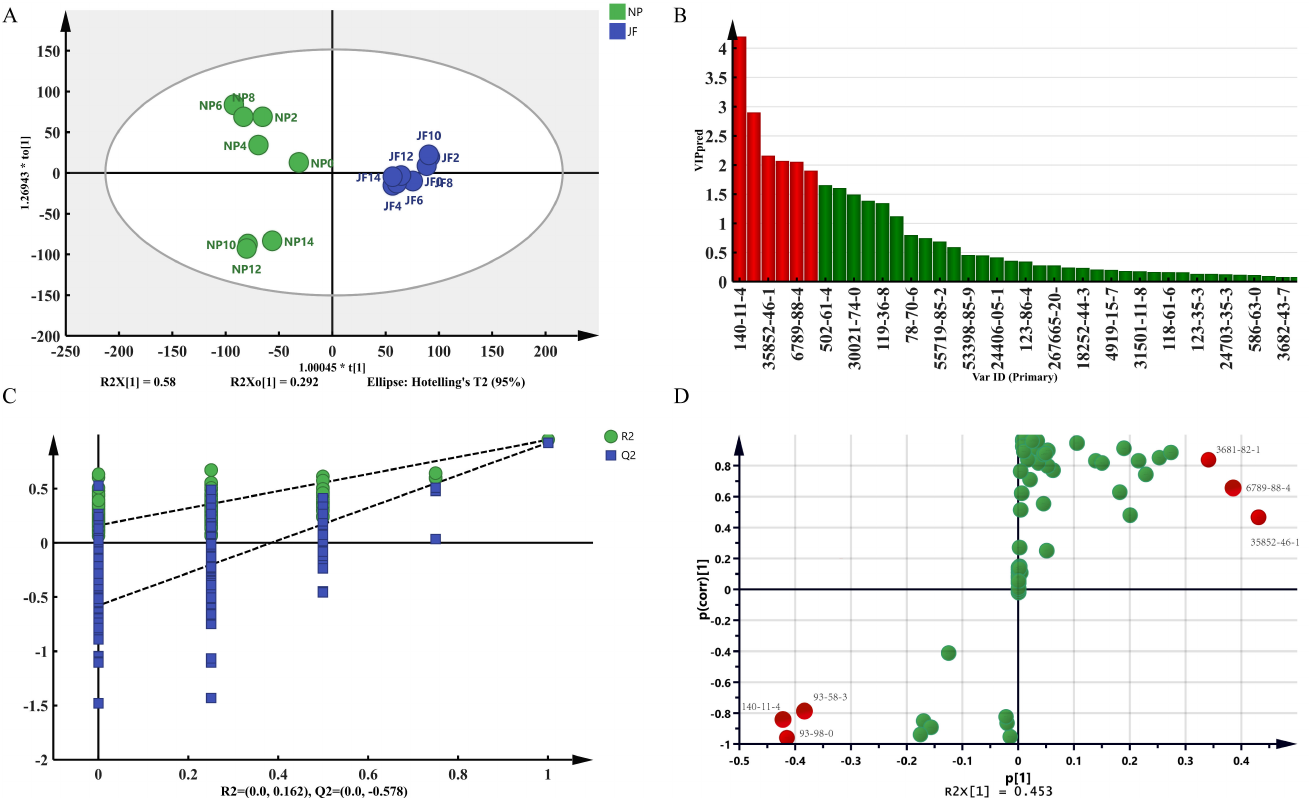
Figure 6. Comparative analysis of volatile components of JF and NP. ( A ) OPLS-DA score plot. ( B ) VIP plot. ( C ) permutation tests plot. ( D ) S-plot. The color in B and D means that differential volatile component is marker in green color; those significant differential volatile components with a VIP > 1 and FC > 1.5 or <0.67 ( p < 0.05) marker in red